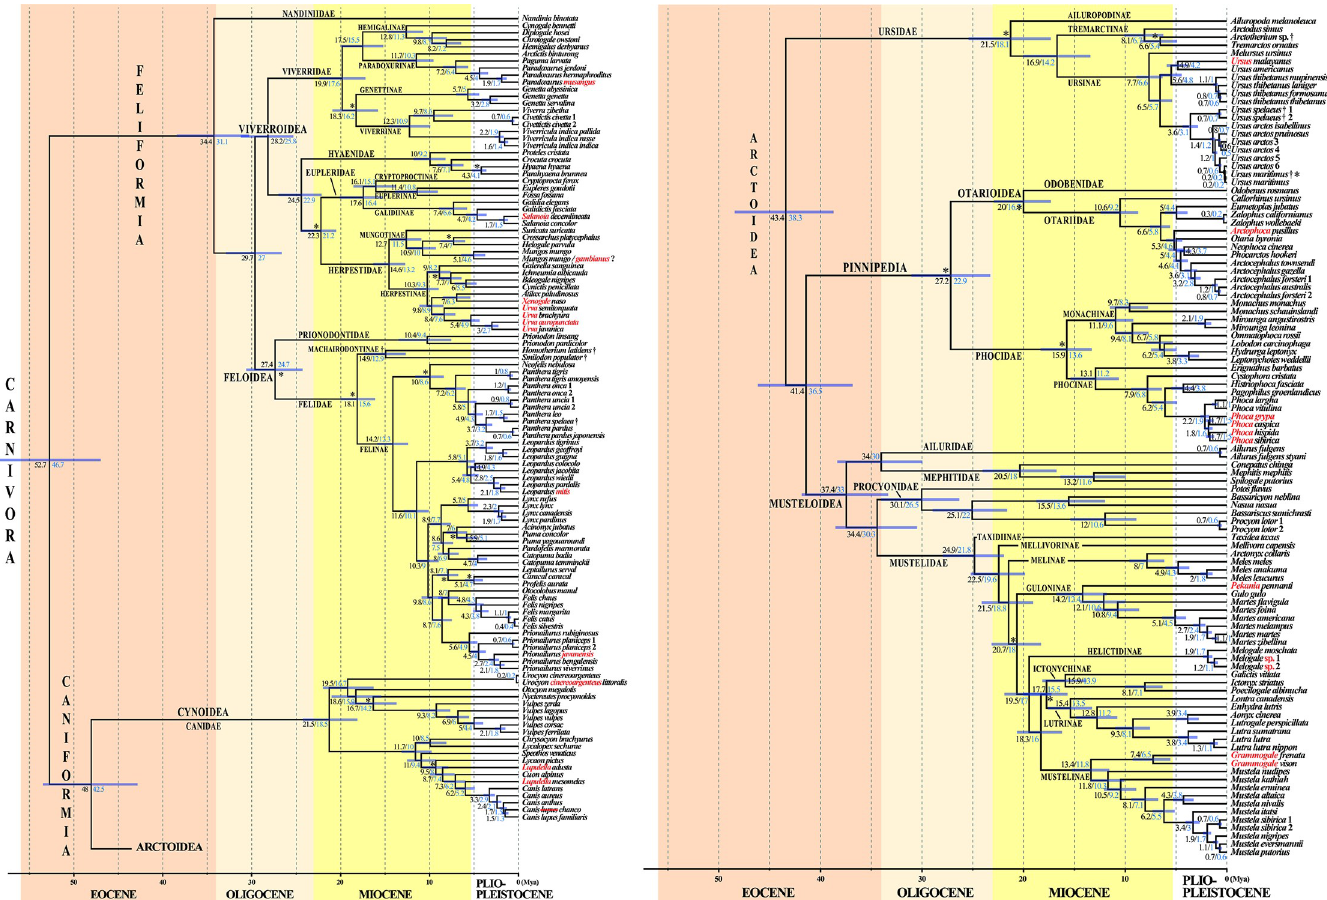
Fig 3. A molecular timescale for carnivoran evolution. The estimates of divergence time were calculated under BEAST v.2.4.7 using the GTR+I+G model on the mtDNA dataset. The asterisks show the 21 fossil calibration points used for molecular estimation (see Table 1 for details). The chronogram, mean ages (values in black) and associated 95% confidence intervals (grey bars) were inferred using a uniform prior distribution for fossil calibration points (“U approach”). For comparison, the values in blue are mean ages estimated using a log normal prior distribution for fossil calibration points (“L approach”; see main text for details and discussion). Species names follow the classification of the IUCN [1]; the name of the taxa written in red have been changed following our results which suggest these taxonomic changes (see the discussion for